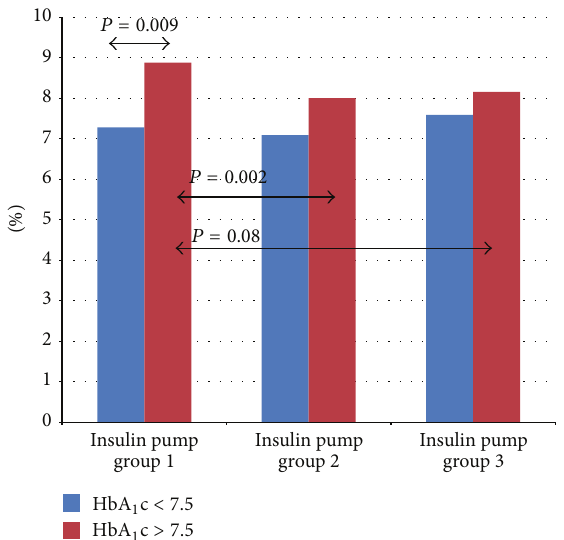
Figure 5: A change in IMT in the groups depending on the initial value of HbA 1 c < 7.5% and > 7.5% (1—before CSII and 3—after 6 months of CSII).